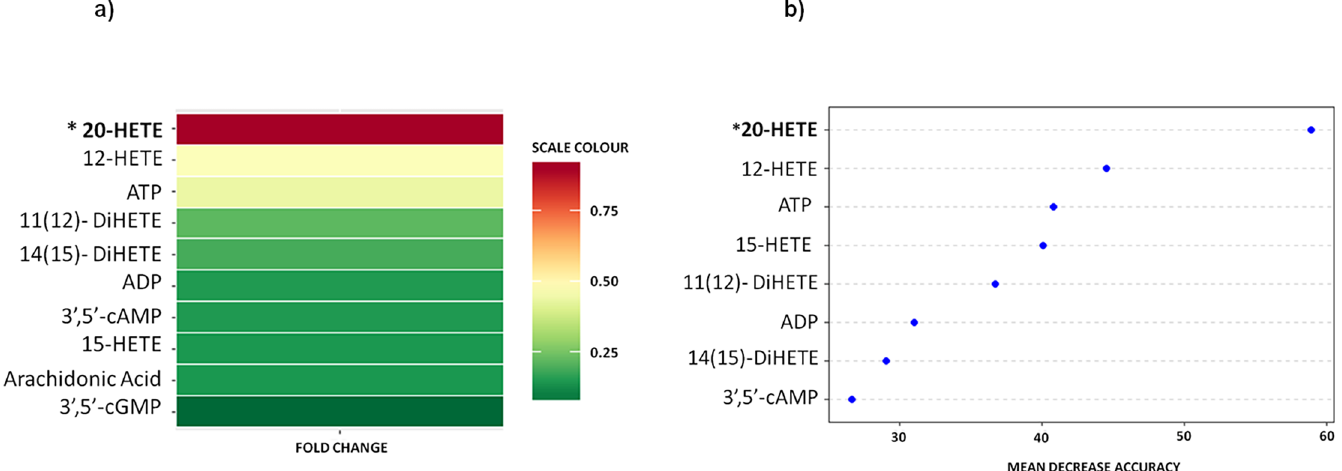
Fig 3. ( a ) The heat map represents the fold-change for each metabolite relative to control subjects (red, greater; green, lower). ( b ) Random (decision) Forest analysis was used as implemented in the R package software as a framework to create a large number of particular models built around the presence or absence of atheroma plaque.